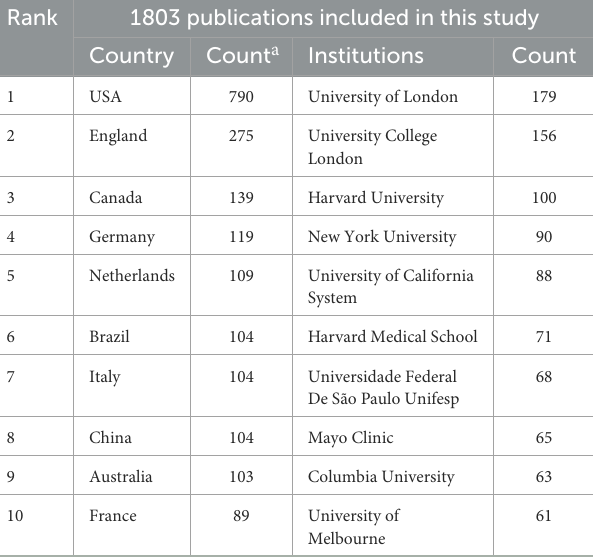
TABLE 2 Top 10 countries and institutions which published the highest number of SUDEP